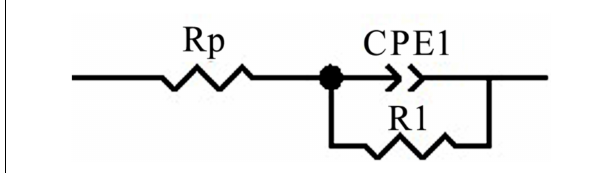
FIGURE 13 | Electrical equivalent circuits (EEC) model to interpret the impedance spectra on the surface of samples.